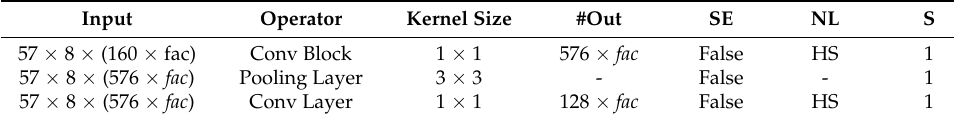
Figure 6. Structure of the similarity discrimination subnetwork. Table 4. Specifications for the similarity discrimination